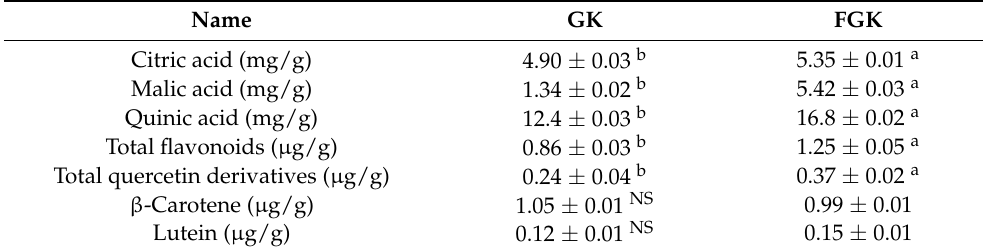
Table 2. Content of organic acids and various active compounds of